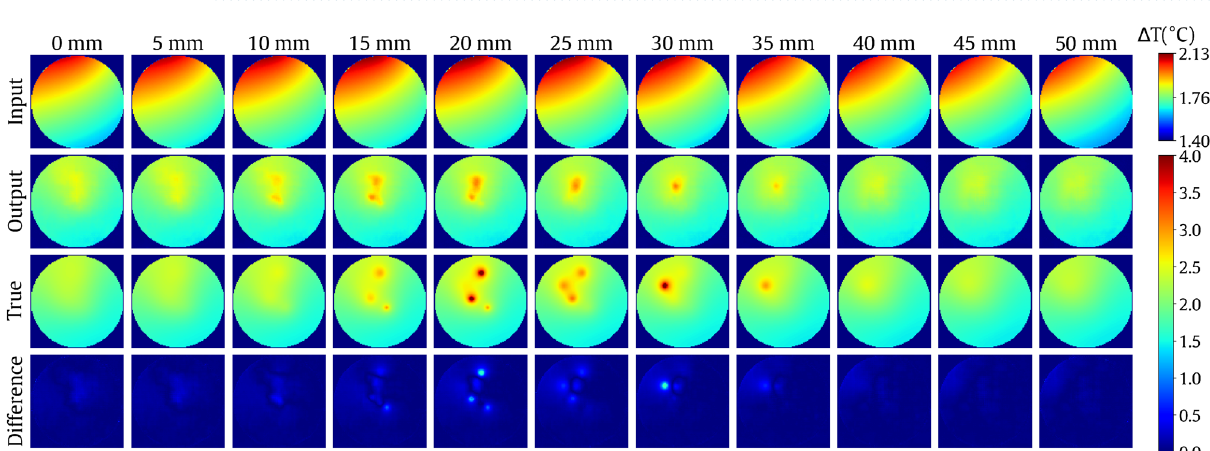
Figure 8. Illustration of the extension of the CNN model from Fig. 4. Added blocks are highlighted with a gray background.